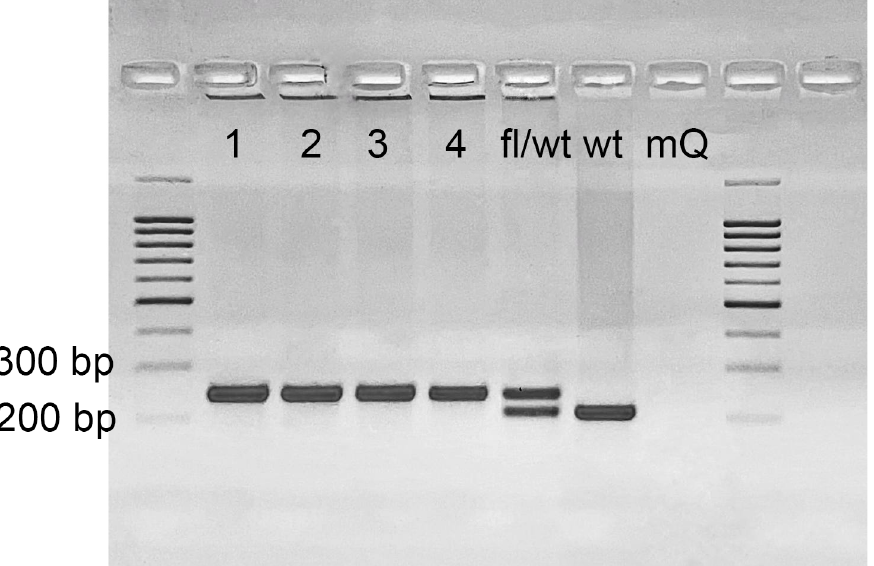
Figure 7. Genotyping of Cdk8 fl/fl mice. 208 bp band corresponds to the wild type allele and 242 band to the floxed allele. “fl/wt”—untreated heterozygous for a floxed exon mouse sample. “wt”—wildtype mouse. mQ—no template control (milliQ water). Lanes 1–4 with 242 bp bands give an example of homozygous for floxed exon samples.